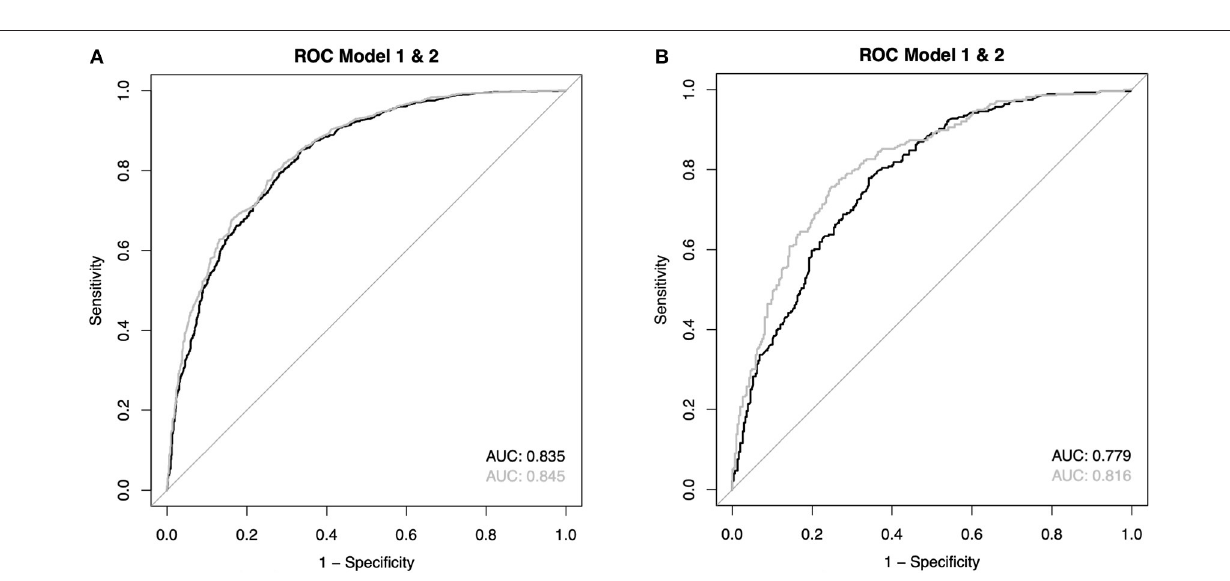
FIGURE 5 | (A,B) Reveicer operating characteristic (ROC) curves of the average values from the imputations (see also Supplementary Material